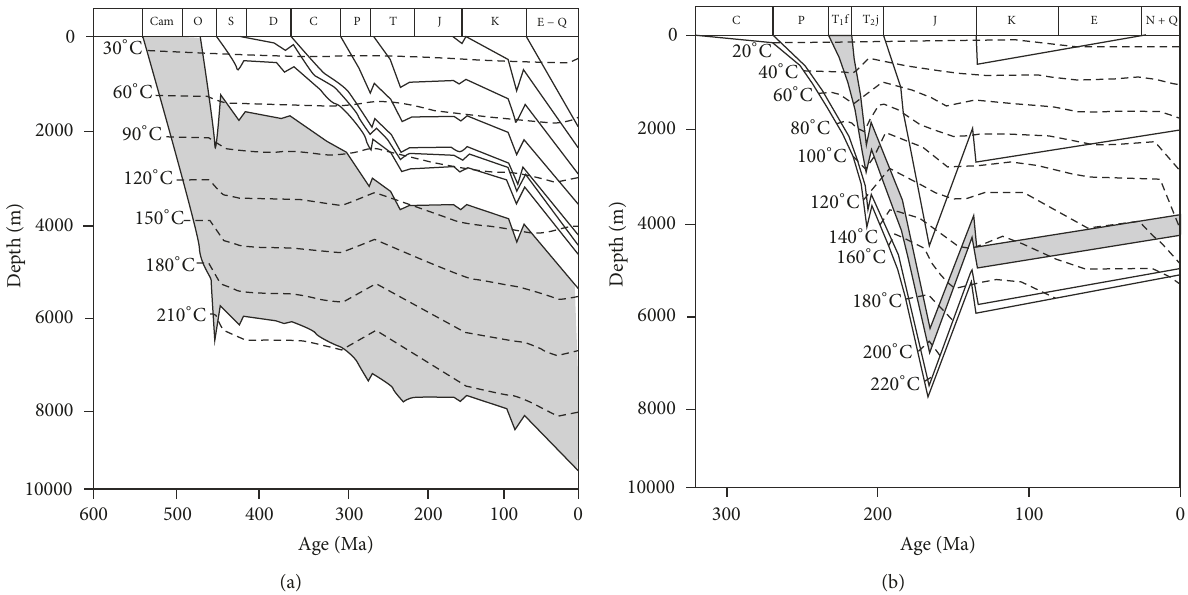
Figure 3: (a) Burial and paleotemperature history of the Ordovician Yingshan Formation (marked with grey color) based on the well TZ12 in the Tazhong area (modified from Chen et al., 2010). (b) Burial and paleotemperature history of the Triassic Feixianguan Formation (marked with grey color) based on the well LJ2 from the Northeast Sichuan Basin (modified from [23]).